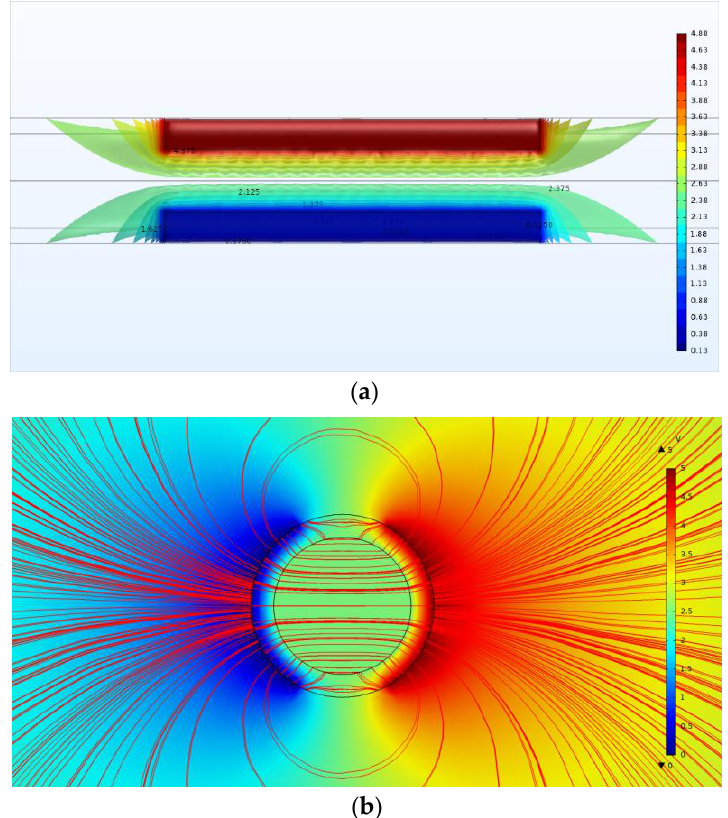
Figure 5. The FEM model: ( a ) The top view of the distribution of the electrical potential; ( b ) The sectional view of the distributions of the electrical potential and the electric field lines.